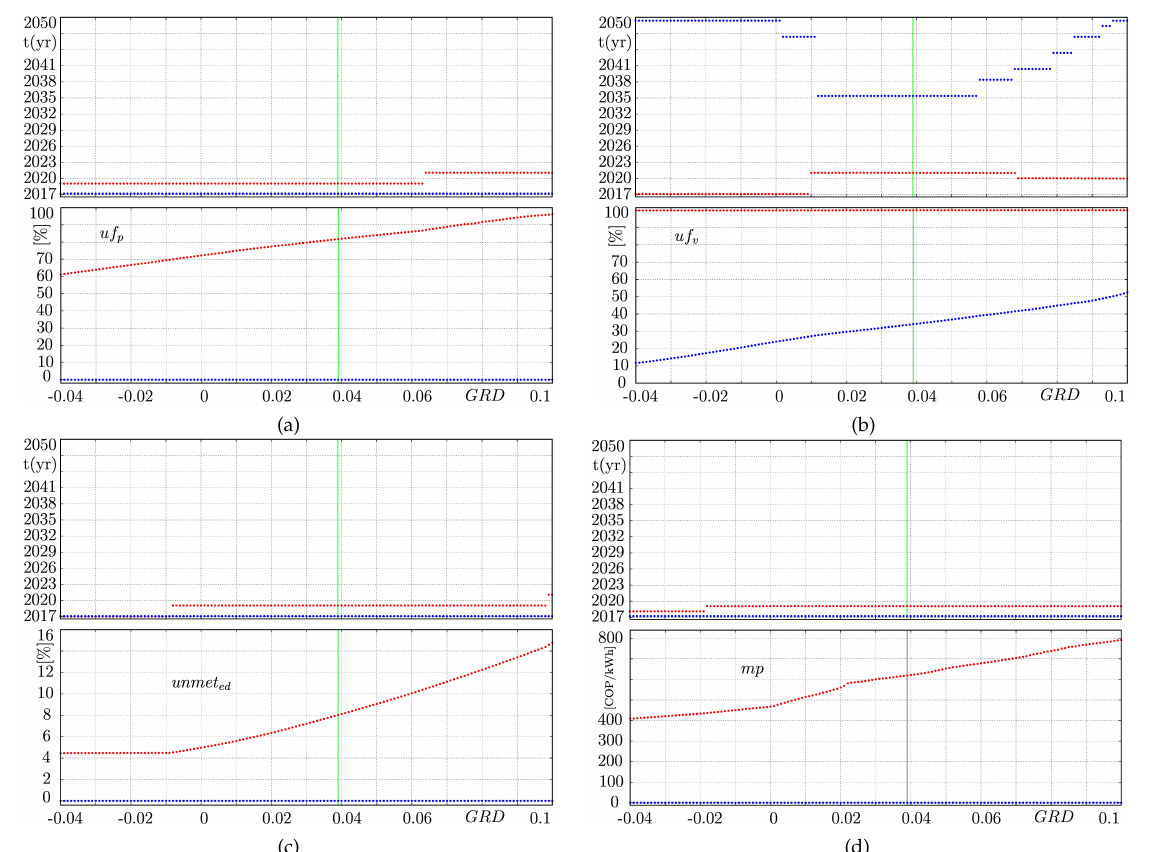
Figure 13. Confidence limits of the GRD scenarios together with the time of occurrence, under seasonality and ENSO phenomenon. The marked green vertical line represents the Colombian case ( GRD = 0.039) ( a ) uf p , ( b ) uf v , ( c ) unmet ed , and ( d ) mp